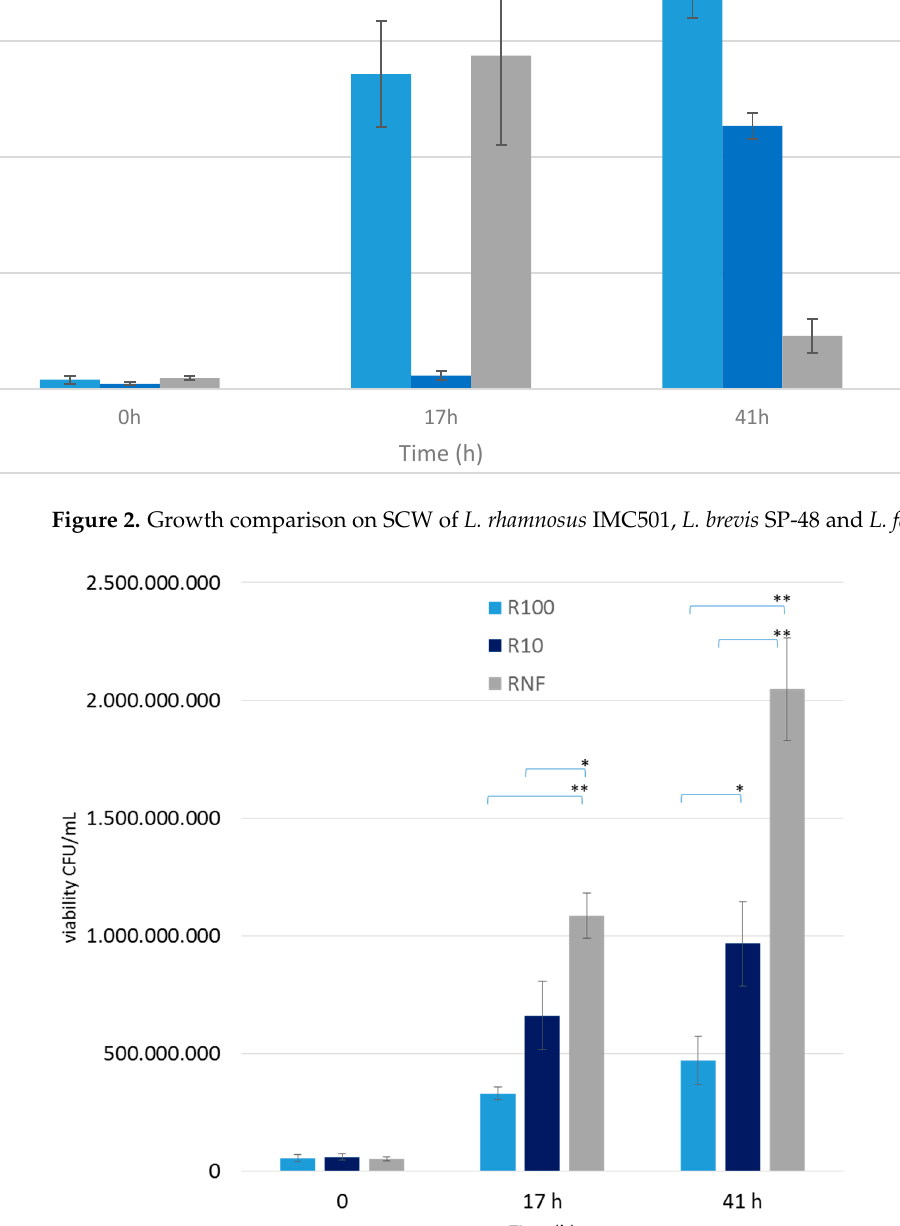
Figure 4. Growth of L. rhamnosus IMC501 on retentate fractions after pasteurization. Data were analyzed by two ‐ tailed non homoscedastic Student’s t ‐ test. ** indicates p < 0.005 (OD600 results); § indicates p < 0.05 (lactate results); §§ indicates p < 0.005 (lactate results).